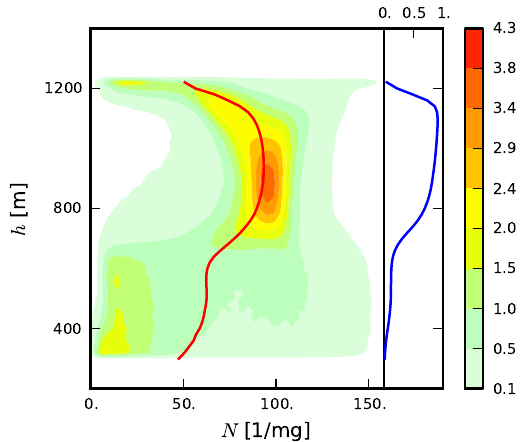
Fig. 9. CFAD of the cloud droplet concentration N ; only cloudy points are included. Red line shows the average profile. The cloud fraction profile is shown on the right-hand side of the panel with the blue line.